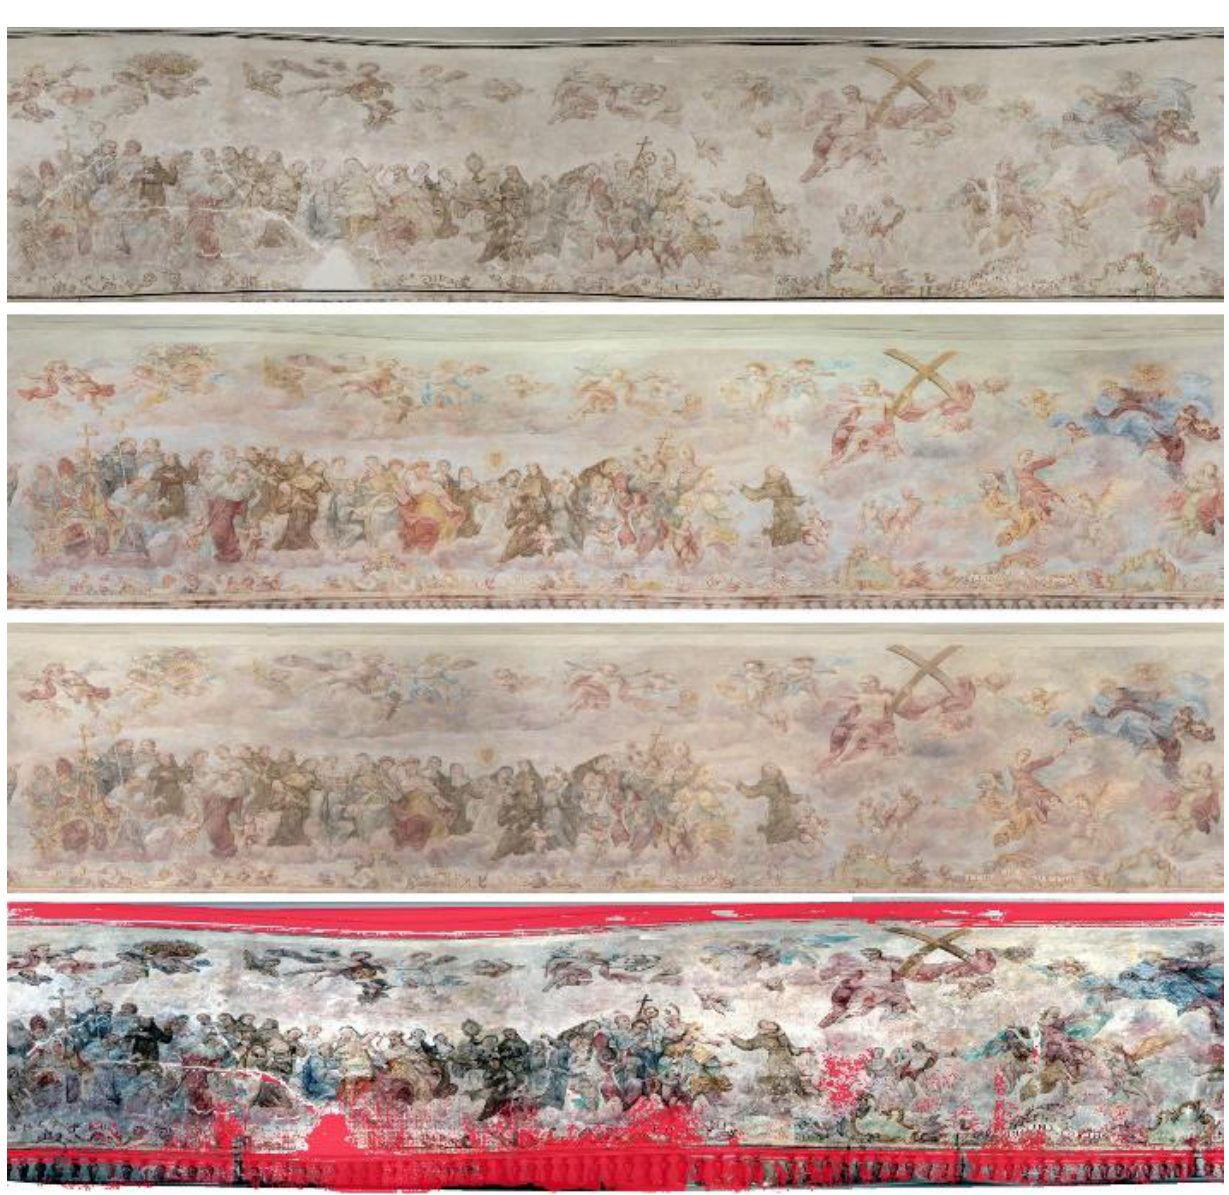
Figure 9: Multitemporal panoramas(before, during and after conservation works) with the map of automated detected areas for conservation works (red